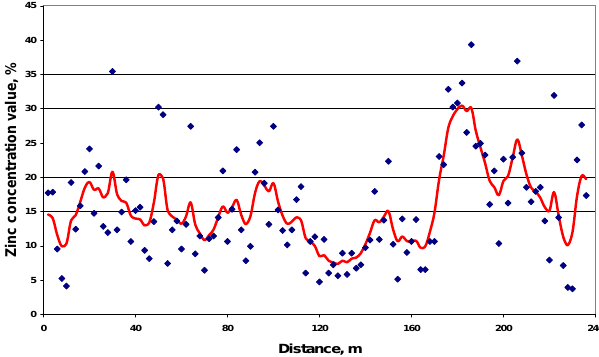
Fig. 1. Pulacayo Mine zinc concentration values for 118 channel samples along horizontal drift. Sampling interval is 2m. Original data (blue diamonds) are from de Wijs (1951) and “signal” (red line) retained after removal of “nugget effect” is from Agterberg